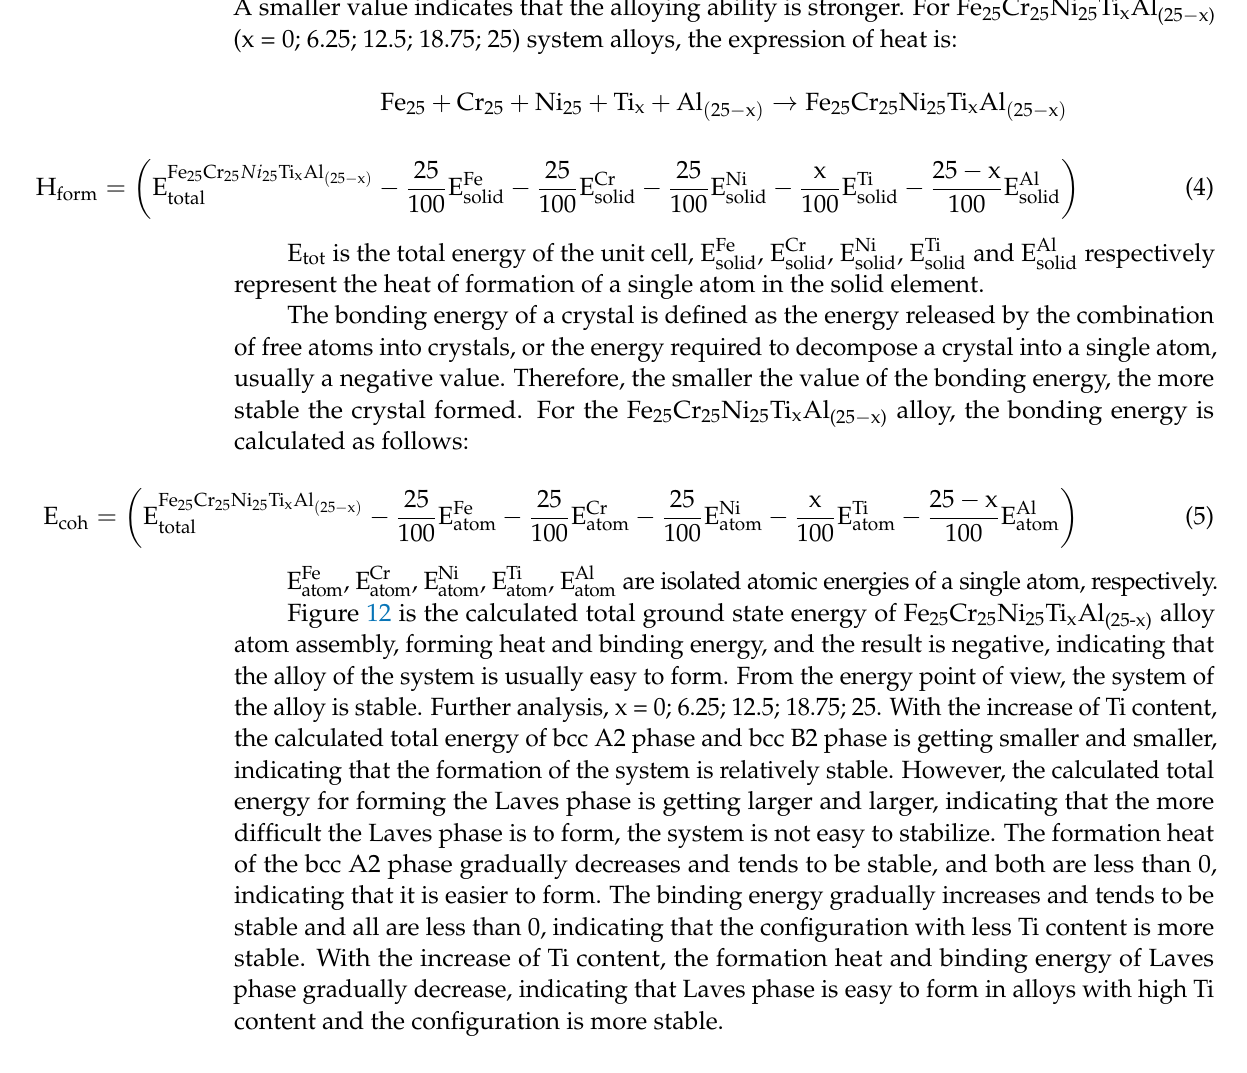
content and the configuration is more